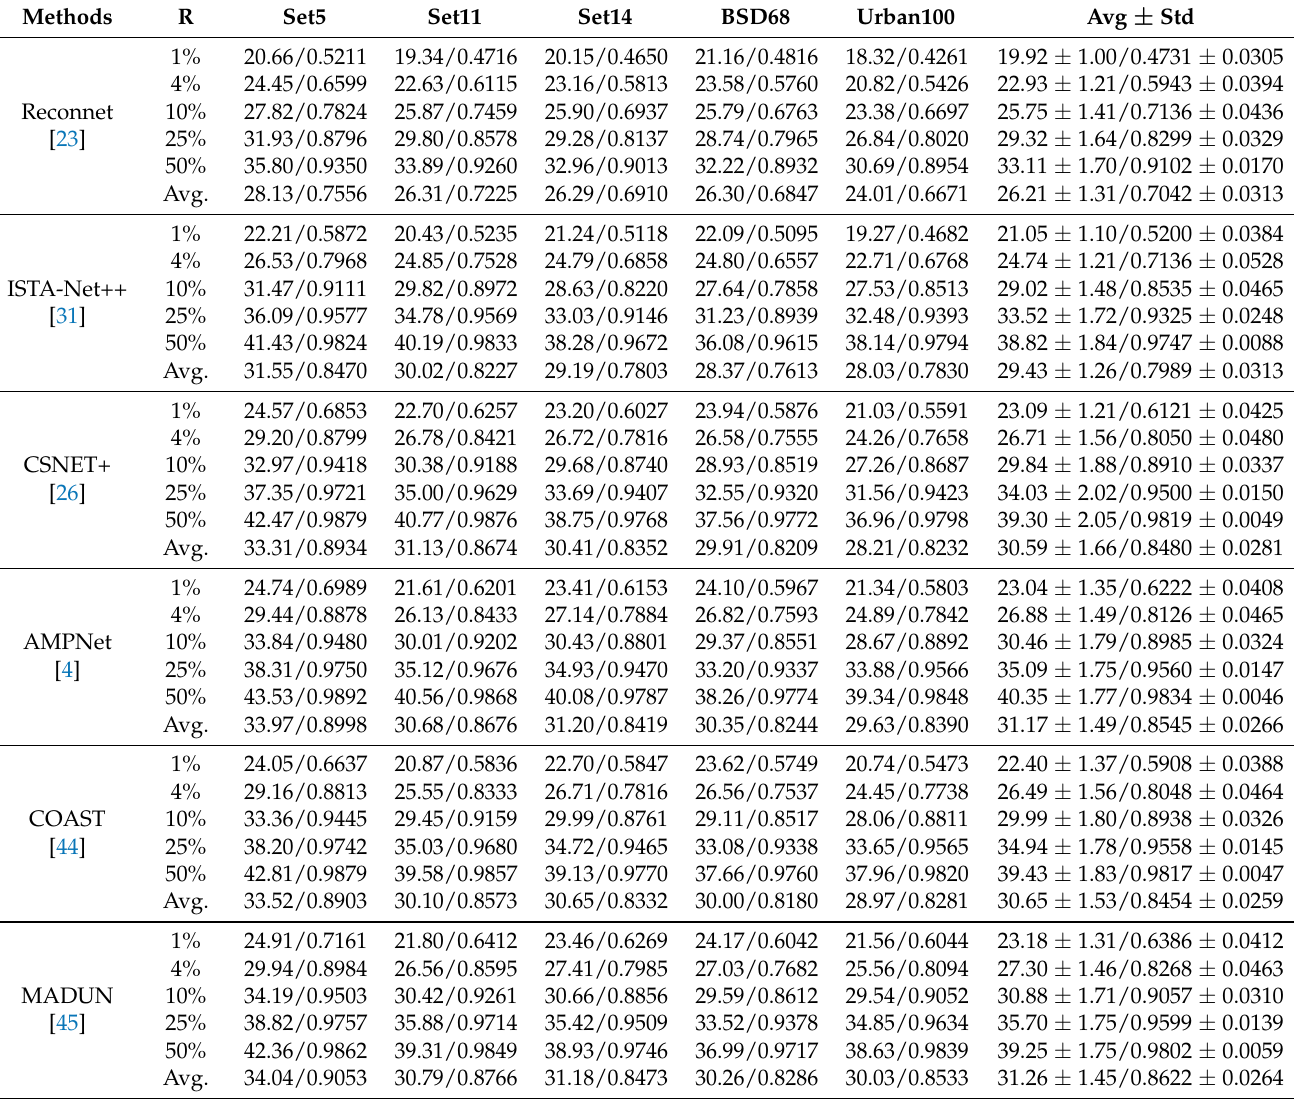
Table 2. The performances of different methods. All methods are tested under five testing datasets and five sampling ratios R . The indicators are shown in PSNR/SSIM